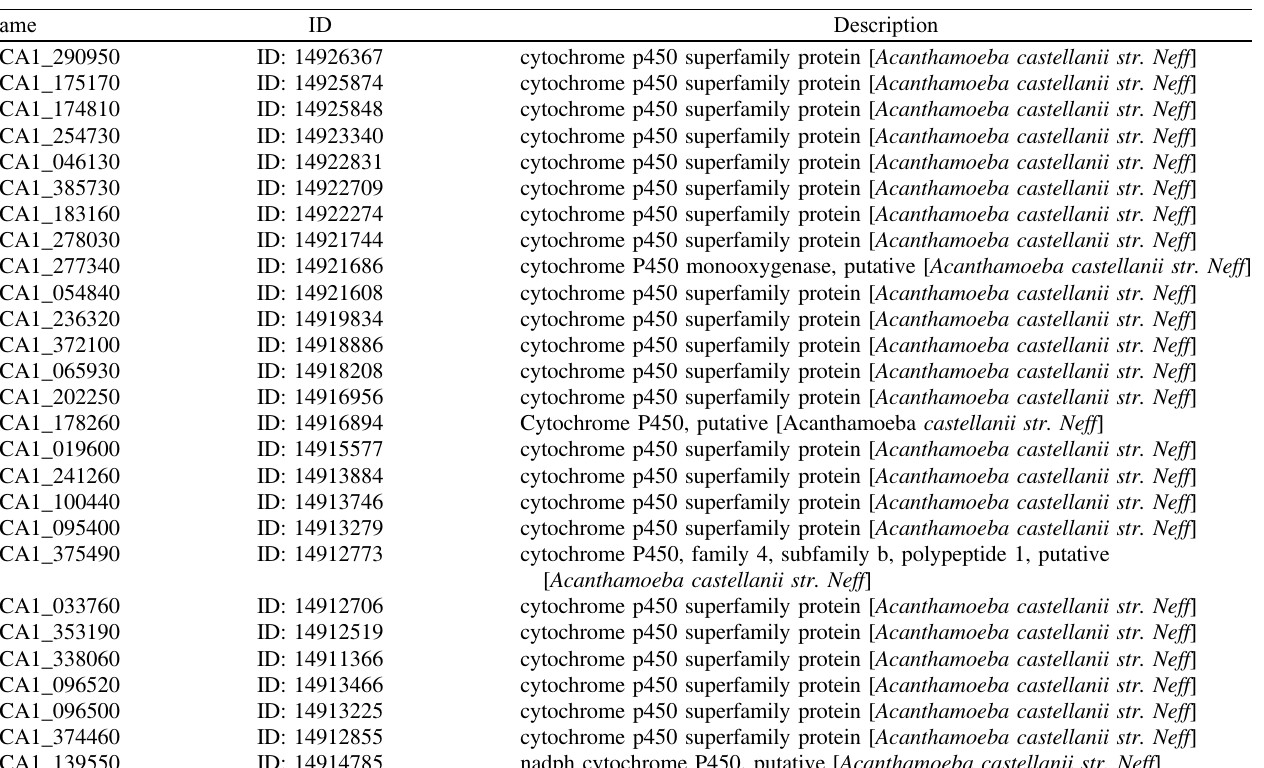
Table 1. Twenty seven related CYP450 enzymes in Acanthamoeba castellanii